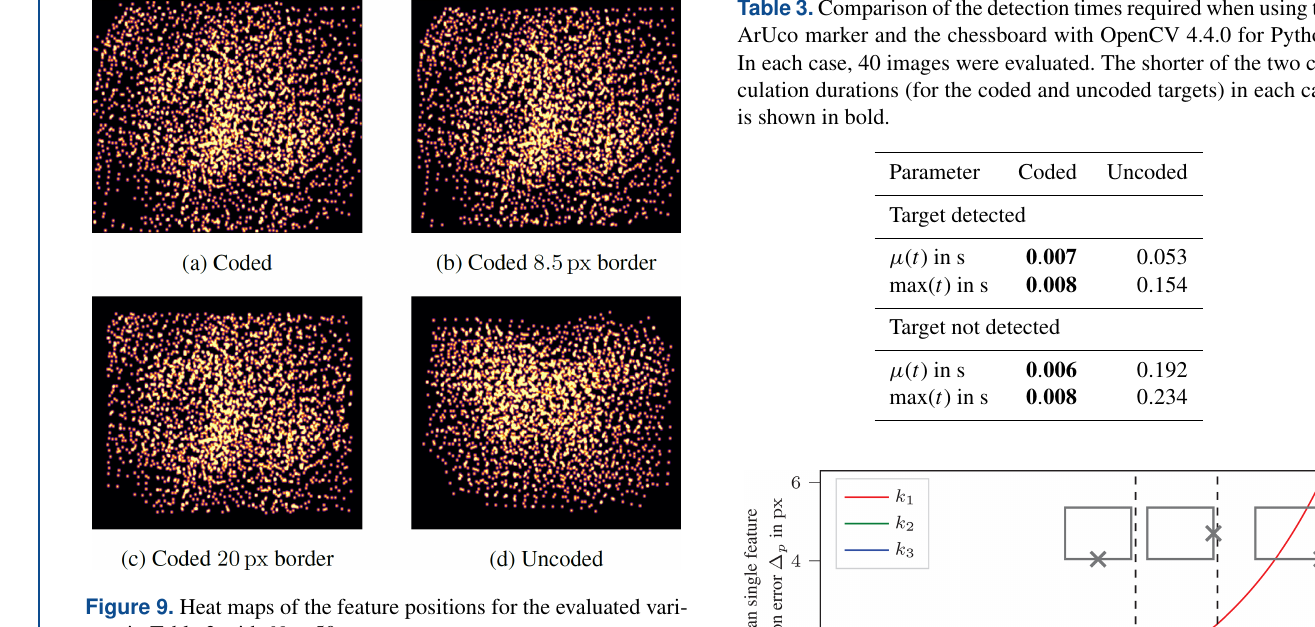
Table 3. Comparison of the detection times required when using the ArUco marker and the chessboard with OpenCV 4.4.0 for Python.